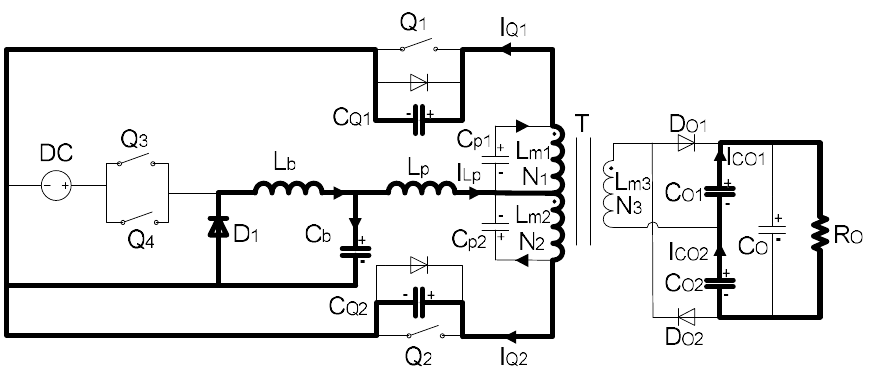
Figure 5. The equivalent circuit of mode I.